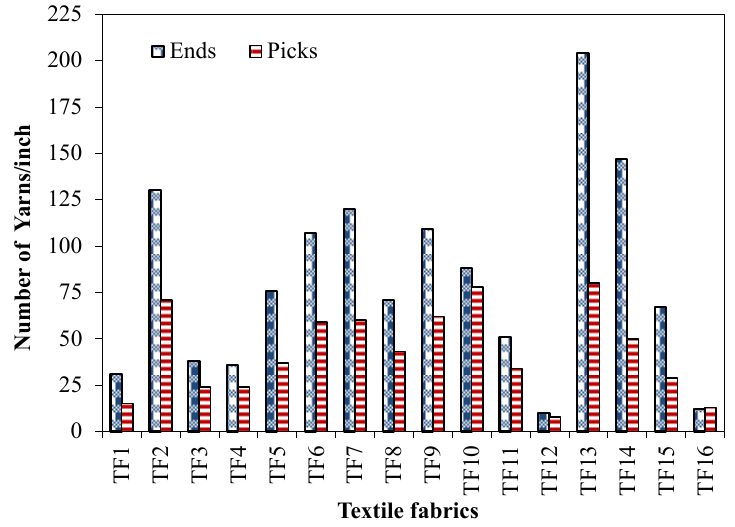
Figure 10. Results of ends (warp) and picks (weft) of tested fabric specimens. Ferdous et al. [37] reported that, irrespective of the weave type for polyester ‐ cotton specimens, their ends and picks densities were 77 and 43, respectively. Banerjee et al. [39] twill weave.